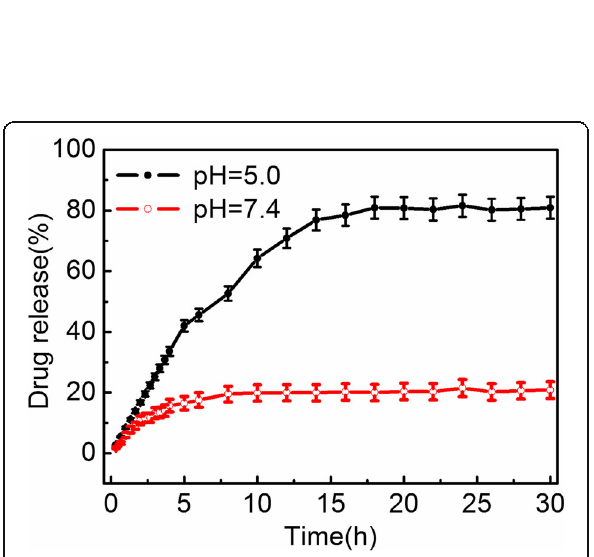
Fig. 5 Plot of the release of DOX from the Fe 3 O 4 NC/PAH/PSS/DOX hybrid nanostructures in PBS buffer at pH 7.4 and 5.0, respectively